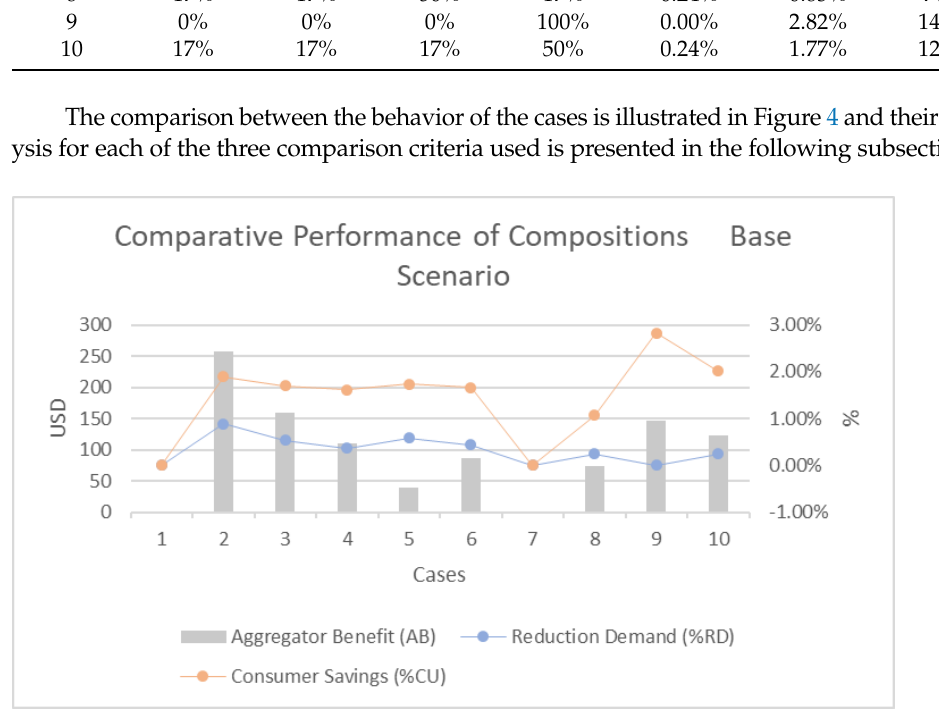
Figure 4. Comparative behavior between compositions—base